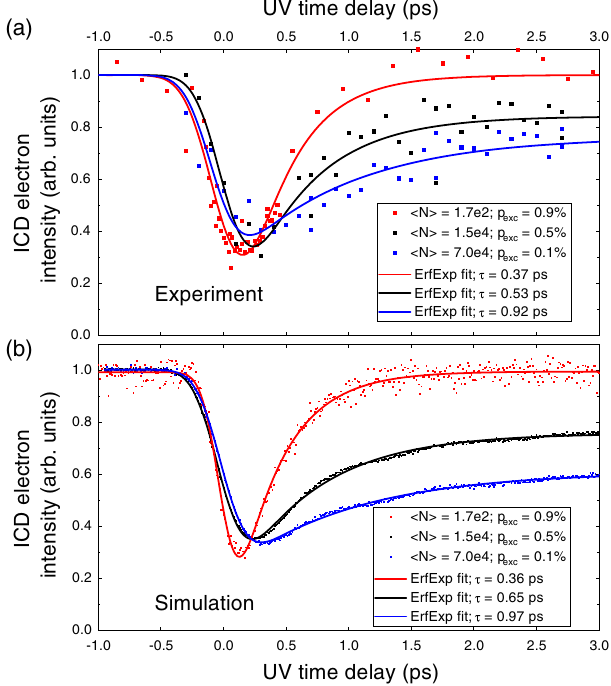
FIG. 7. (a) Experimental ICD electron intensities as a function of XUV-UV pump-probe delay with corresponding exponential fits for three different droplet sizes and excitation densities. (b) Simulated ICD electron intensities and fits for conditions similar to those of the upper